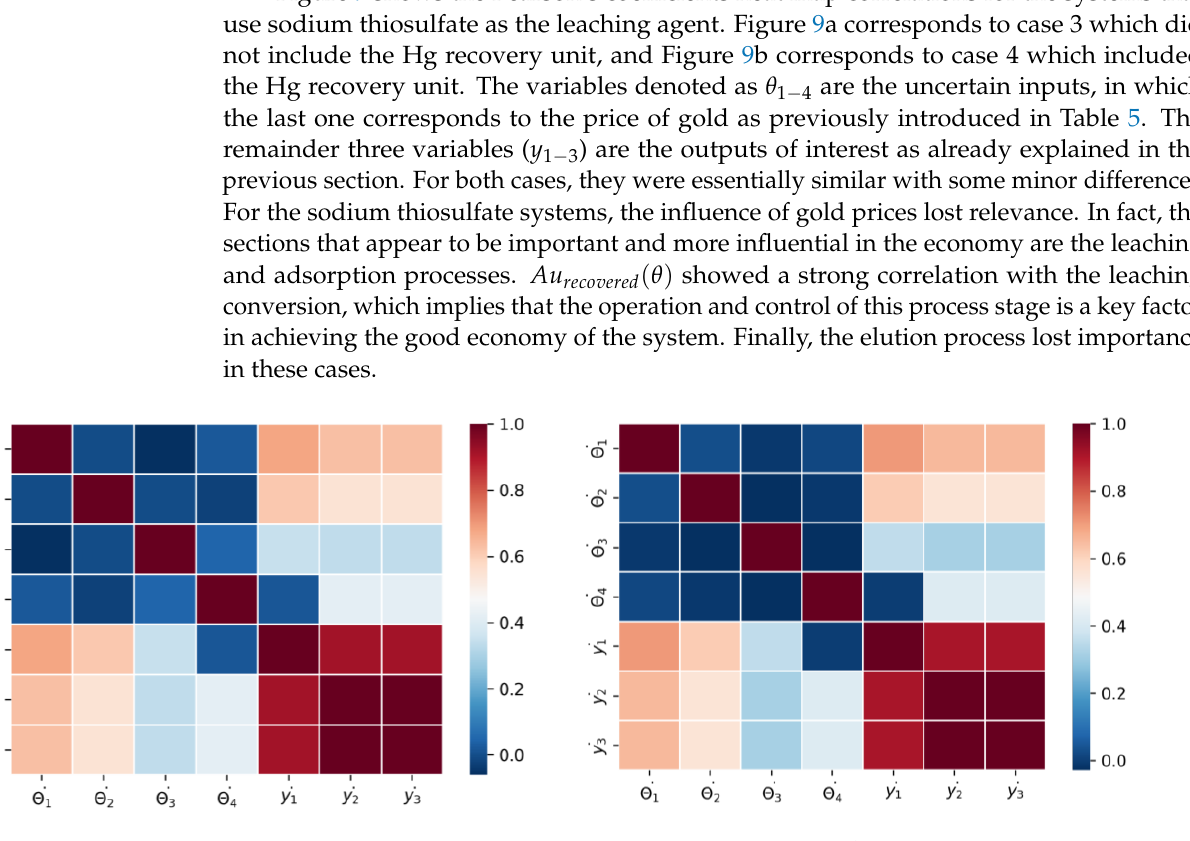
Figure 8. Pairwise bivariate distribution of the outputs for the systems using sodium thiosulfate as leaching agent. The blue results correspond to the samples that do not include Hg removal, and the orange results correspond to the samples that include Hg removal.